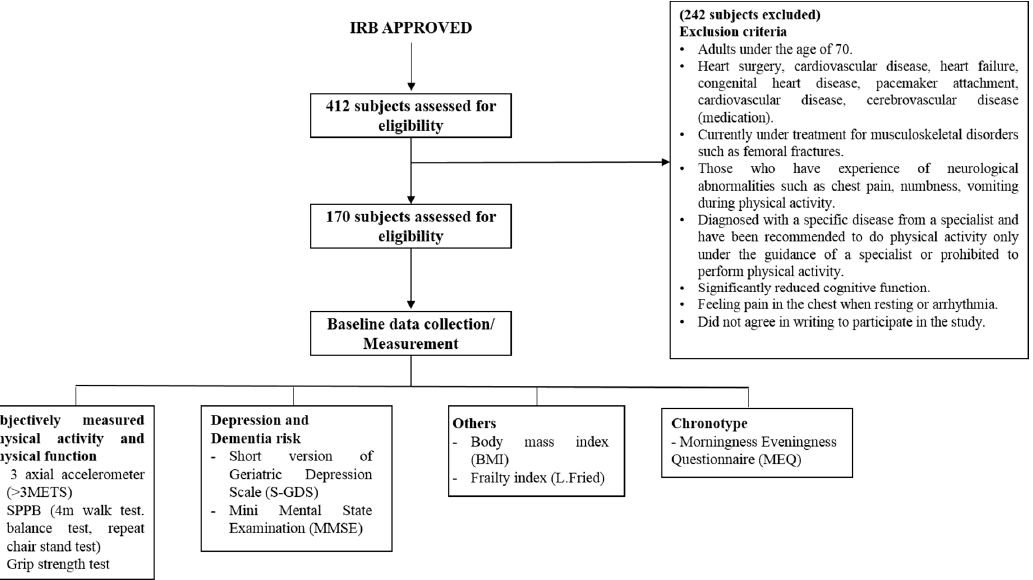
Figure 1. Flowchart explaining the screening procedure of participants, baseline data collection, and measurement methods.